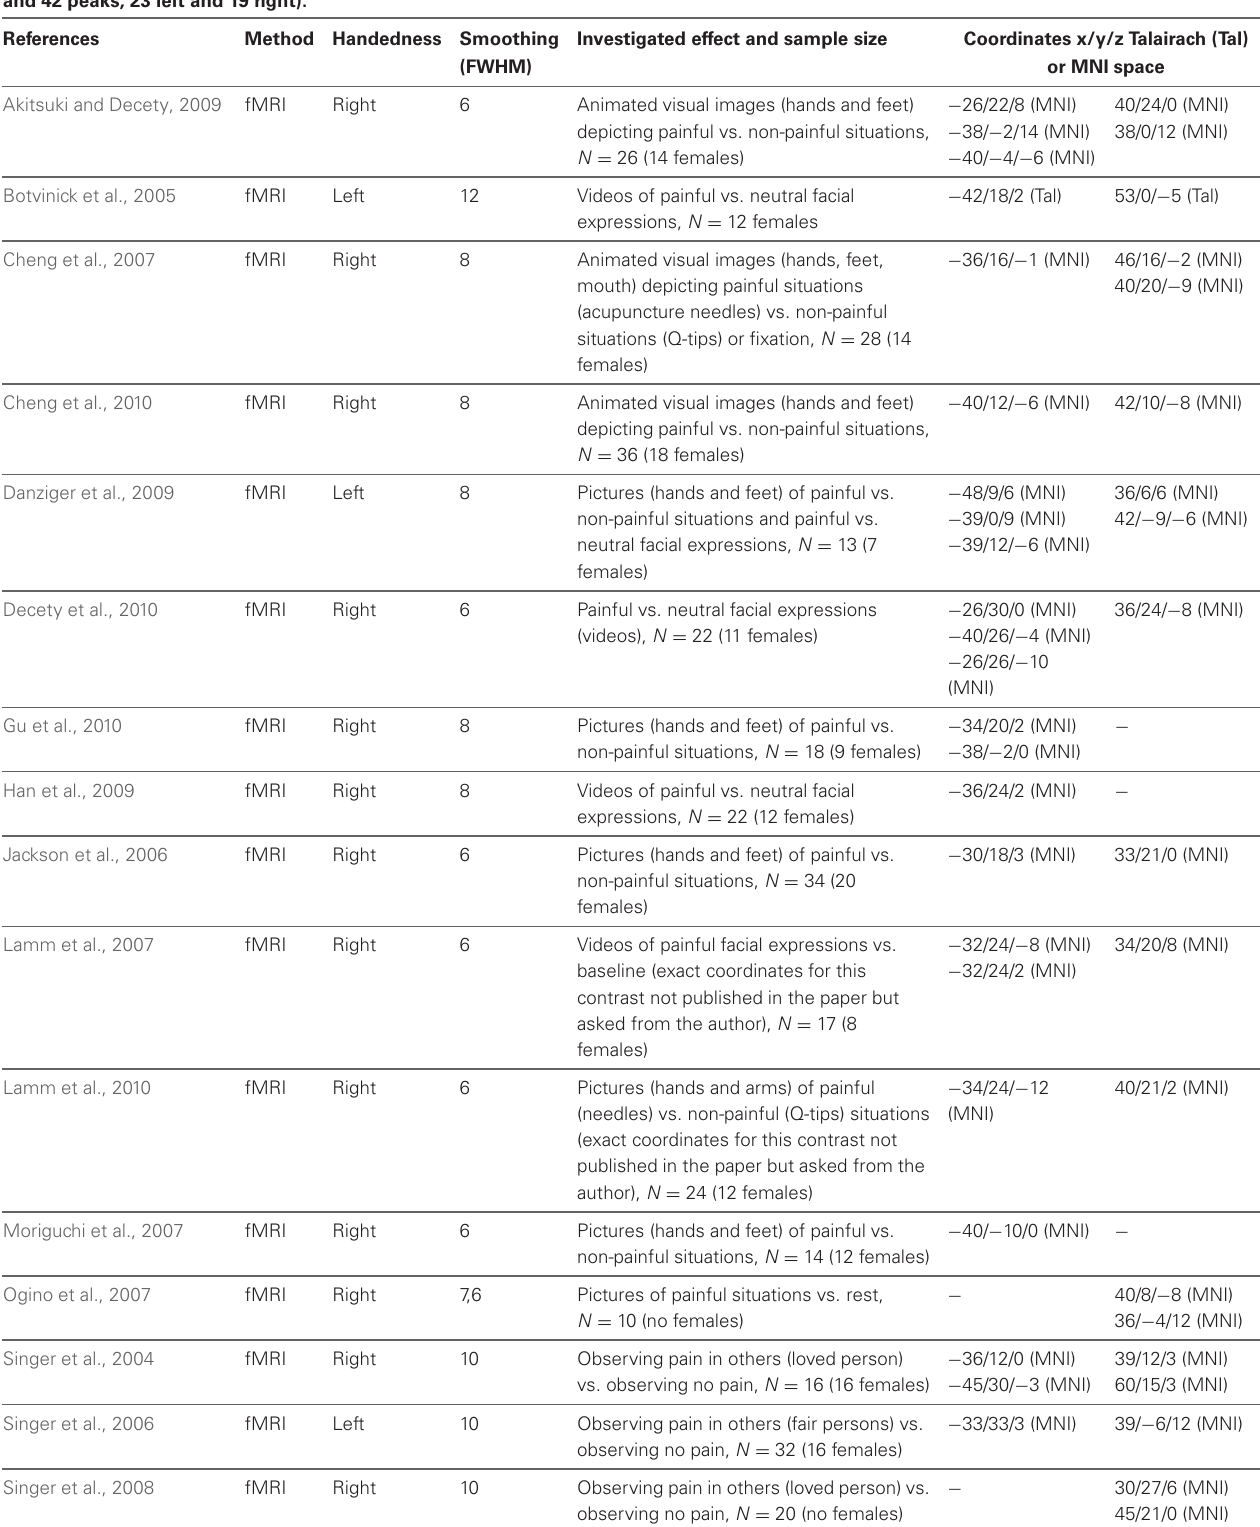
Table A | Sixteen fMRI imaging studies reporting anterior insula activity related to empathy for pain (comprising 344 individuals, 191 females, and 42 peaks, 23 left and 19